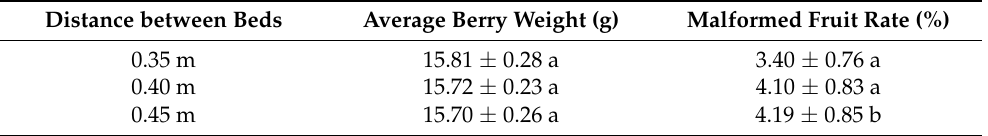
Table 8. Impacts of the distance between beds.